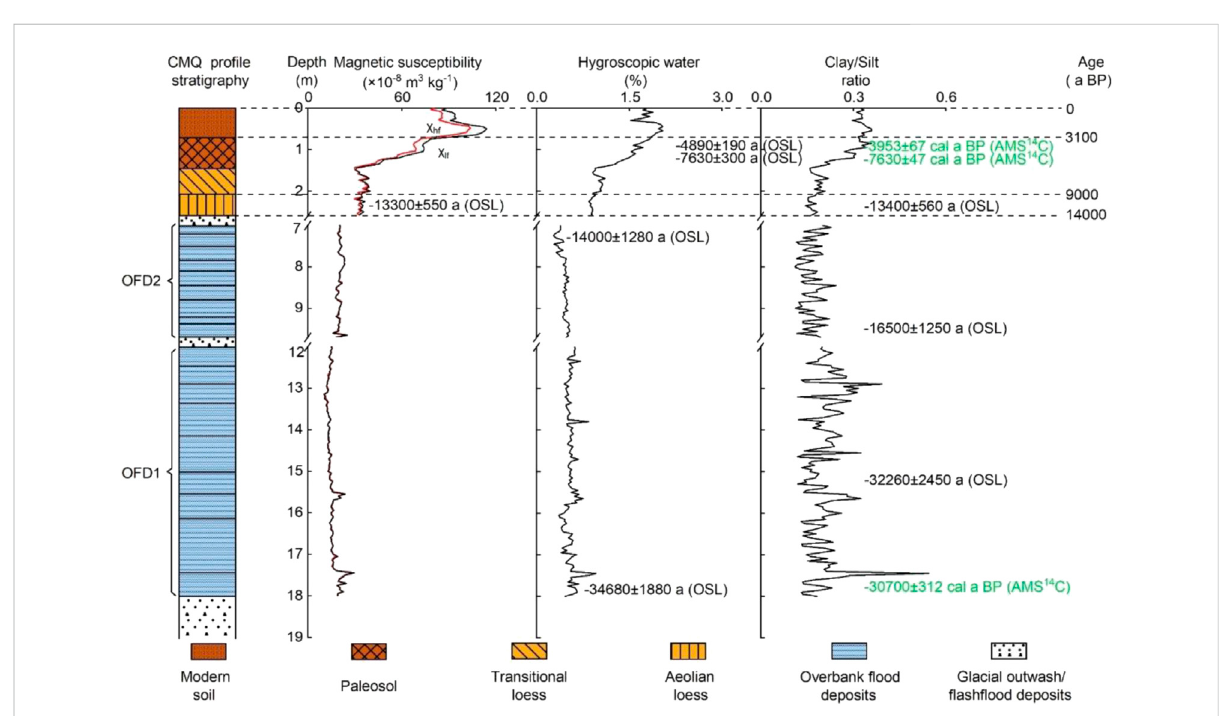
FIGURE 6 Pedo-stratigraphy, magnetic susceptibility, hygroscopic water concentration, clay/silt ratio in the CMQ pro fi le in the Yellow River source area on the NE Tibetan